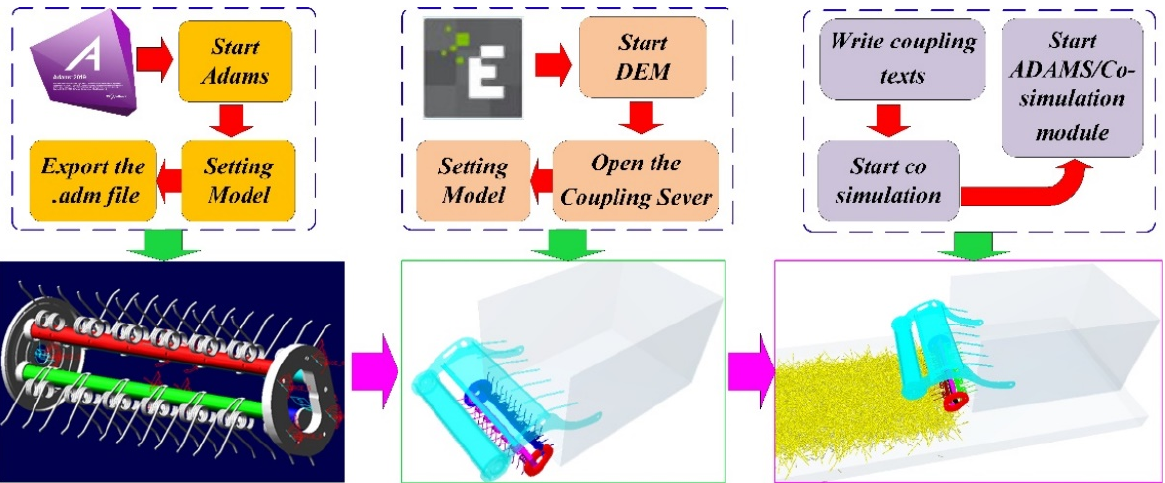
Figure 4. ADAMS-DEM coupling simulation process.